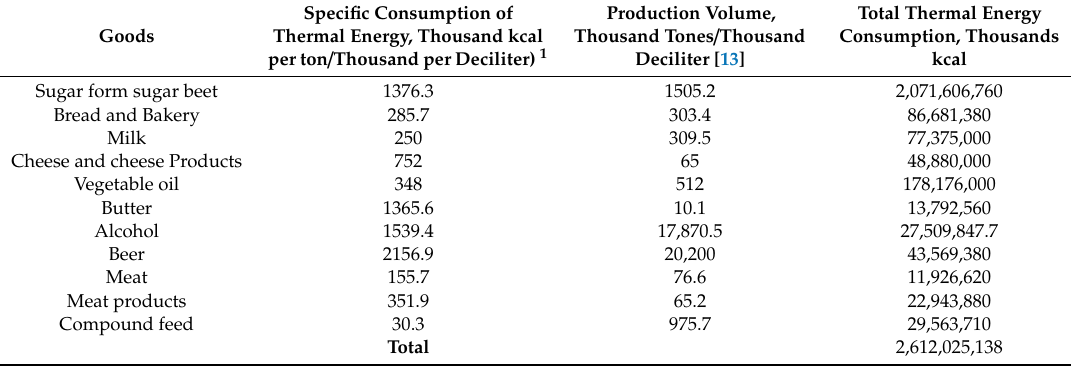
Table 5. An assessment of thermal energy consumption by food industry enterprises of the Krasnodar